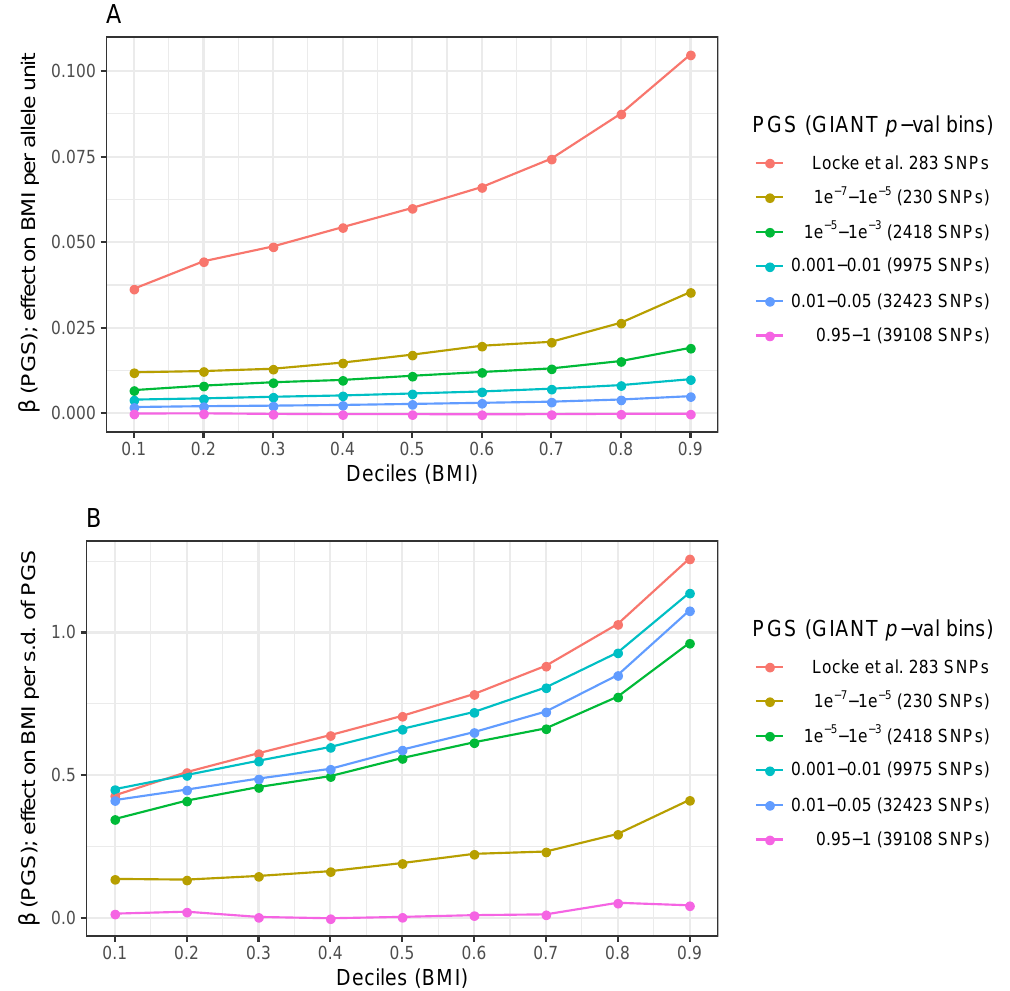
Figure 2. The effect of polygenic scores for BMI varies across the BMI distribution. Summary of the effects that six unweighted polygenic scores (PGS) have by decile of the BMI distribution in the UK Biobank cohort. The ordinary least squares (OLS) estimates of the effect on raw BMI per allele and per standard deviation of the weighted PGS ( Y -axis for panel A and B , respectively) are plotted against the corresponding decile of BMI ( X -axis). As noted in the legend, each PGS was calculated by combining SNPs associated with BMI at different statistical thresholds in the GIANT consortium meta-analysis (see Methods Section 2.4 Quantile Regression Analyses ). A list of SNPs used for calculating each PRS, including risk allele, are available in Supplementary Table